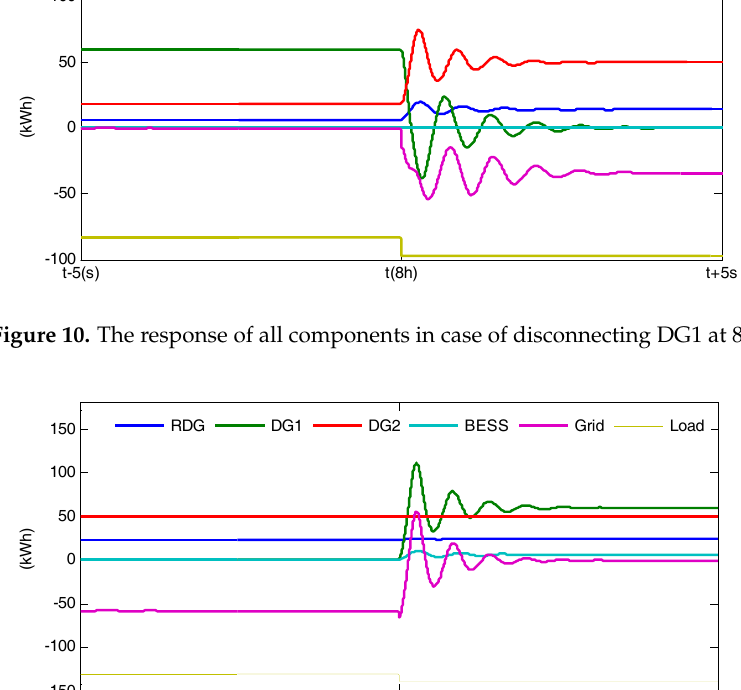
Figure 9. Schedule for all components considering the events at 8 h and 10 h.